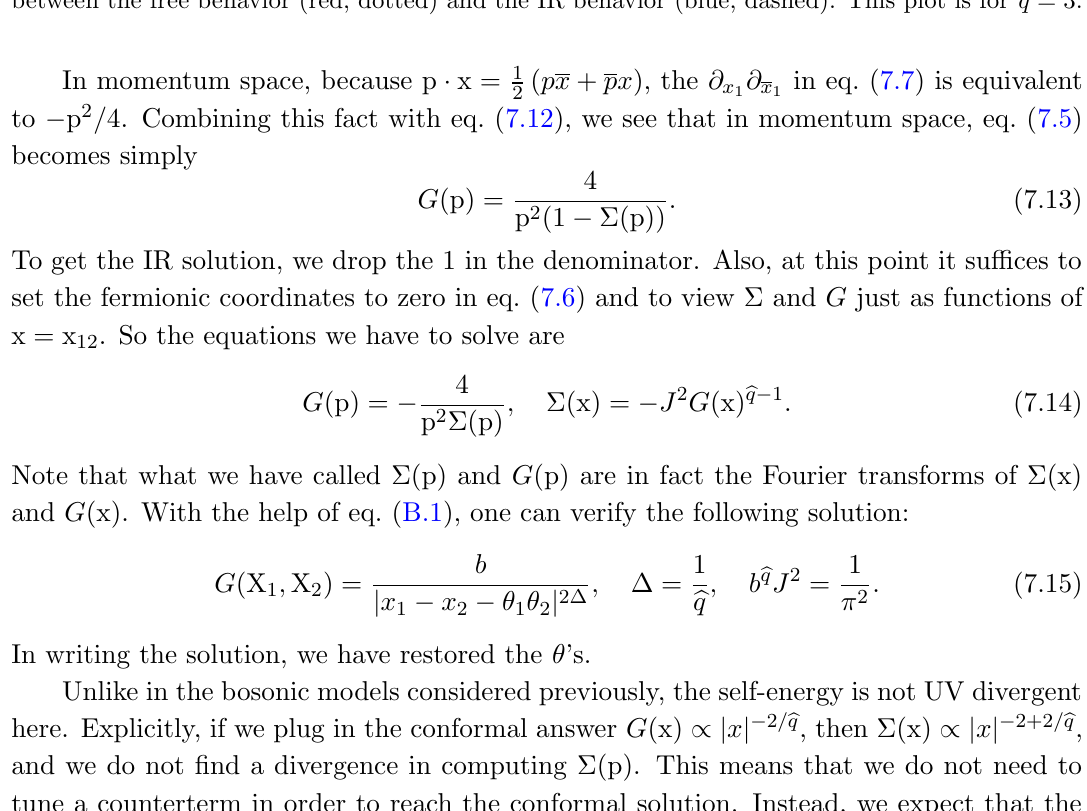
Figure 7 . The numerical solution of the exact supersymmetric SD equations (black) interpolates between the free behavior (red, dotted) and the IR behavior (blue, dashed). This plot is for b q =